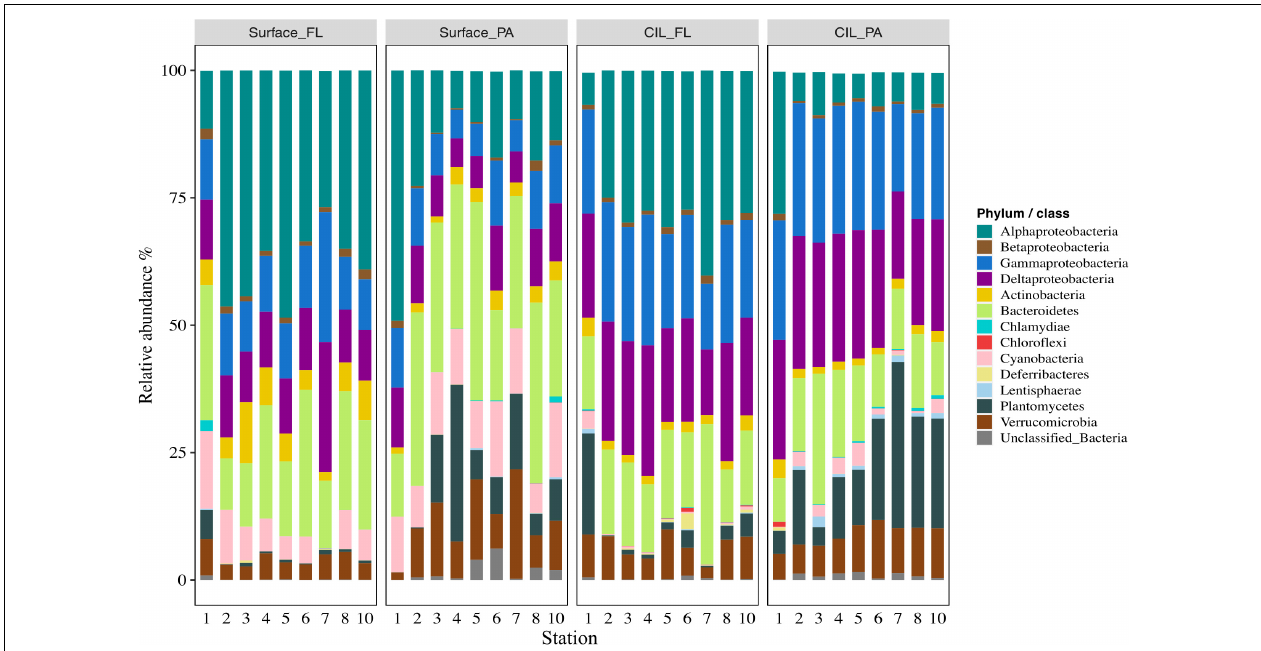
FIGURE 3 | The succession of the dominant bacterial phyla (i.e., collectively > 1% relative abundance across samples) of the St.Lawrence Estuary. The mean relative abundances of the (sub-)phyla within the FL and PA communities at two depths, the surface and the cold intermediate layer (CIL) (Surface_FL, Surface_PA, CIL_FL, and CIL_PA), are shown. “Unidentified_Bacteria” represent OTUs that could not be assigned at the phylum level. The phylum Proteobacteria is divided into Alpha-, Beta-, Delta-, and Gamma-proteobacteria.